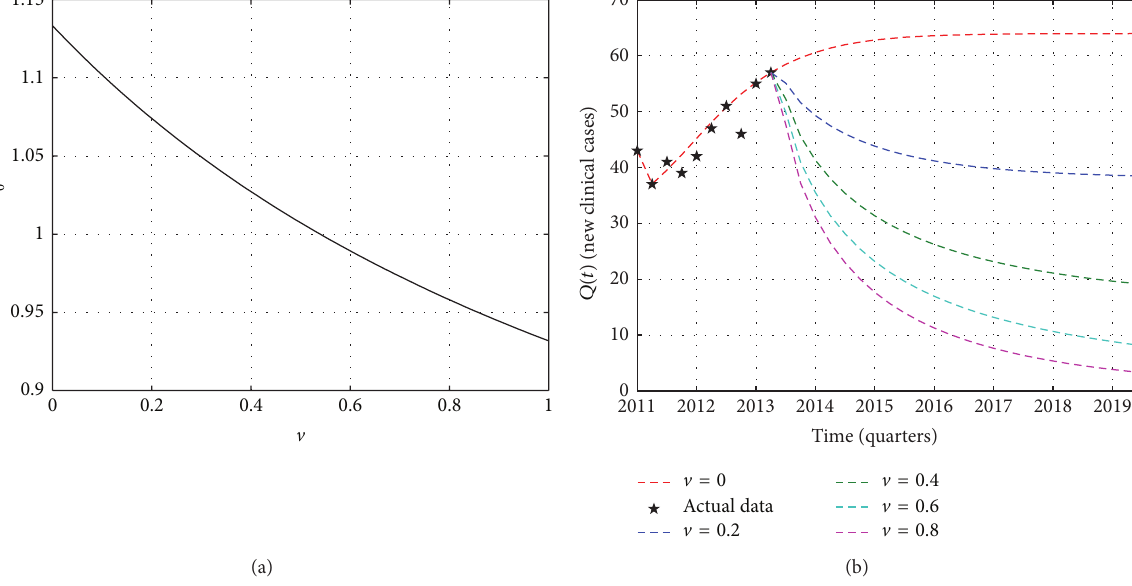
transmission model with stage structure for S. suis . It is found that the model has two nonnegative equilibria, the disease- free equilibrium and the endemic equilibrium. The disease- free equilibrium exists without any condition whereas the endemic equilibrium exists provided R 0 > 1 .